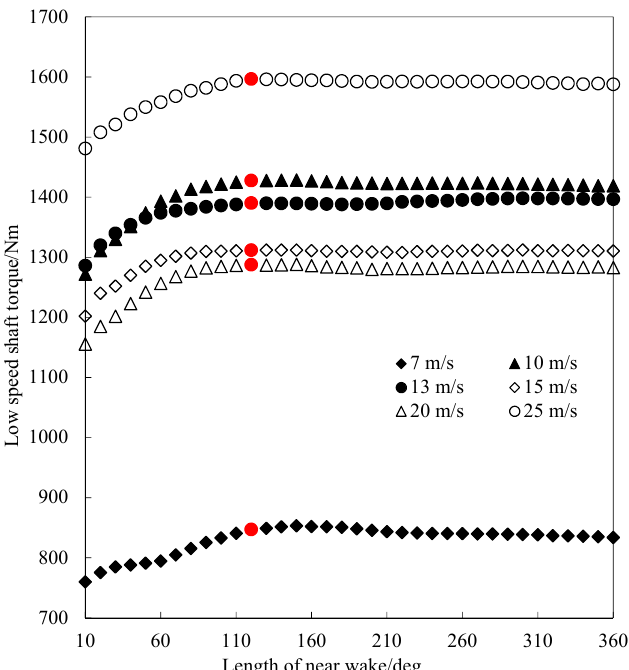
Figure 7. LSST along the length of the near wake at different wind speeds (The red points are the LSST values with a near wake age angle of 120°).